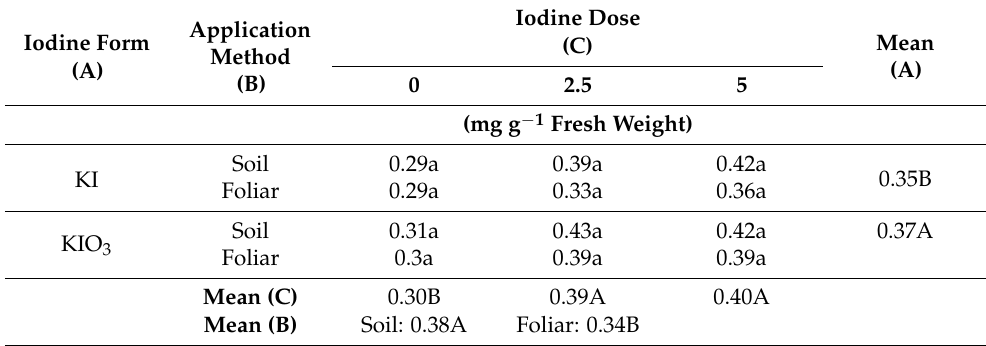
Table 7. Content of sugar in rye plants depending on I dose, form, and method of